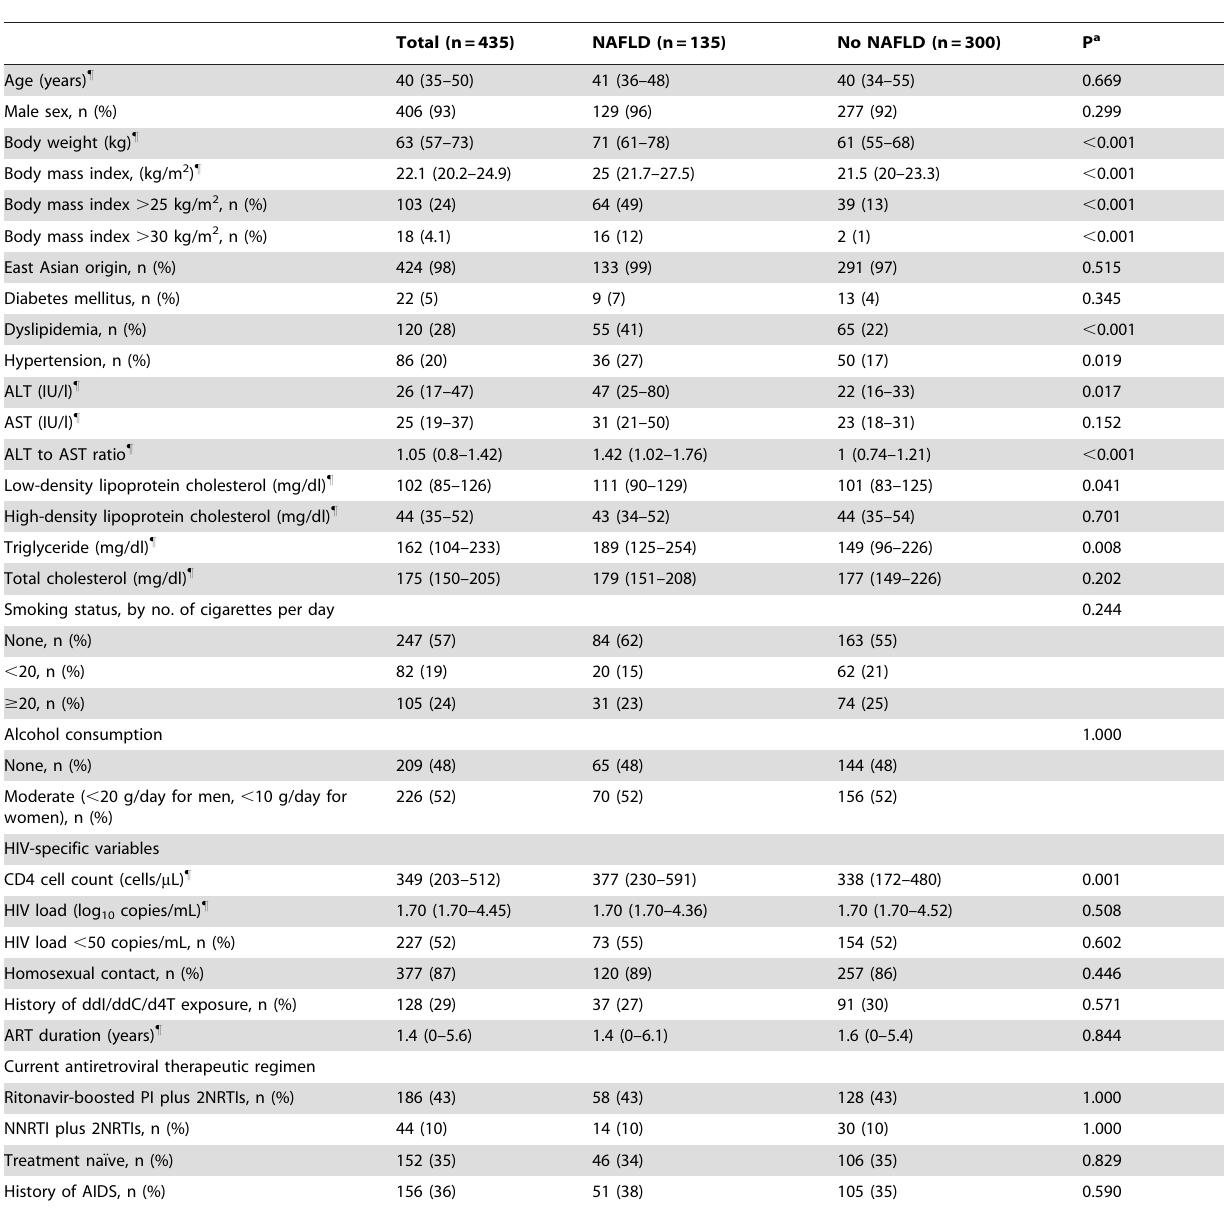
Table 1. Basic demographics of the entire study population, patients with NAFLD and without